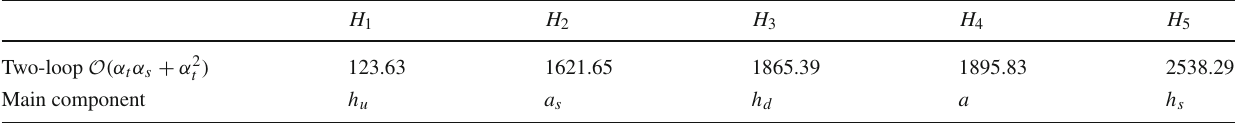
Table 6 Scenario2 : Mass values in GeV and main components of the neutral Higgs bosons at two-loop order O (α t α s + α 2 t ) obtained by using the DR renormalization in the top/stop sector H